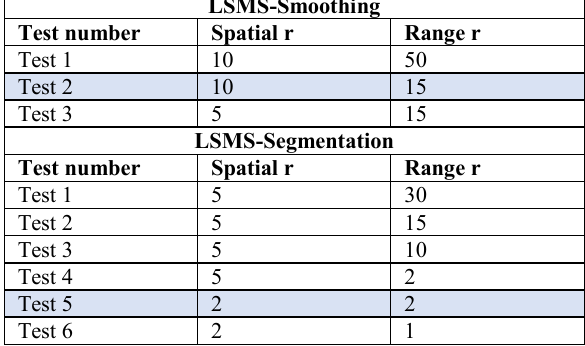
Table 7. Spatial radius and range radius parameters tested to obtain the most effective segmentation result. Table 5. Summary of processing parameters and accuracy results of the Alexander Stream National Park site's digital products.